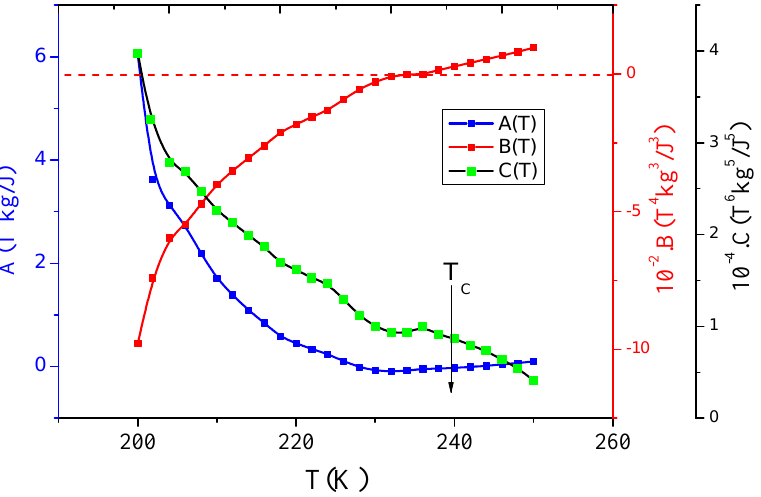
Figure 8. Landau parameter A (T 2 kg/J) (black y -axis), B (T 4 kg 3 /J 3 ) (red y -axis), and C (T 6 kg 5 /J 5 ) (blue y -axis) plotted against temperature around the T C for SmNi 2.2 Fe 0.8